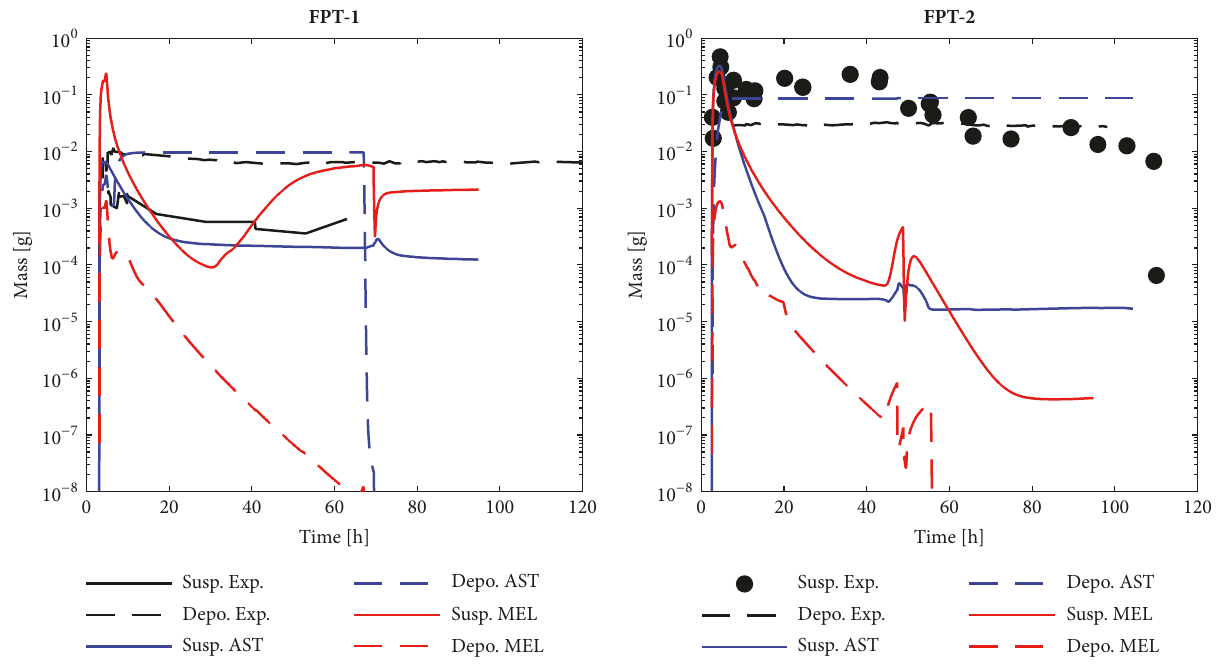
Figure 12: Deposited iodine mass on wet condenser’s surfaces, and suspended iodine mass in the atmosphere during the Ph´ebus FPT-1 and FPT-2